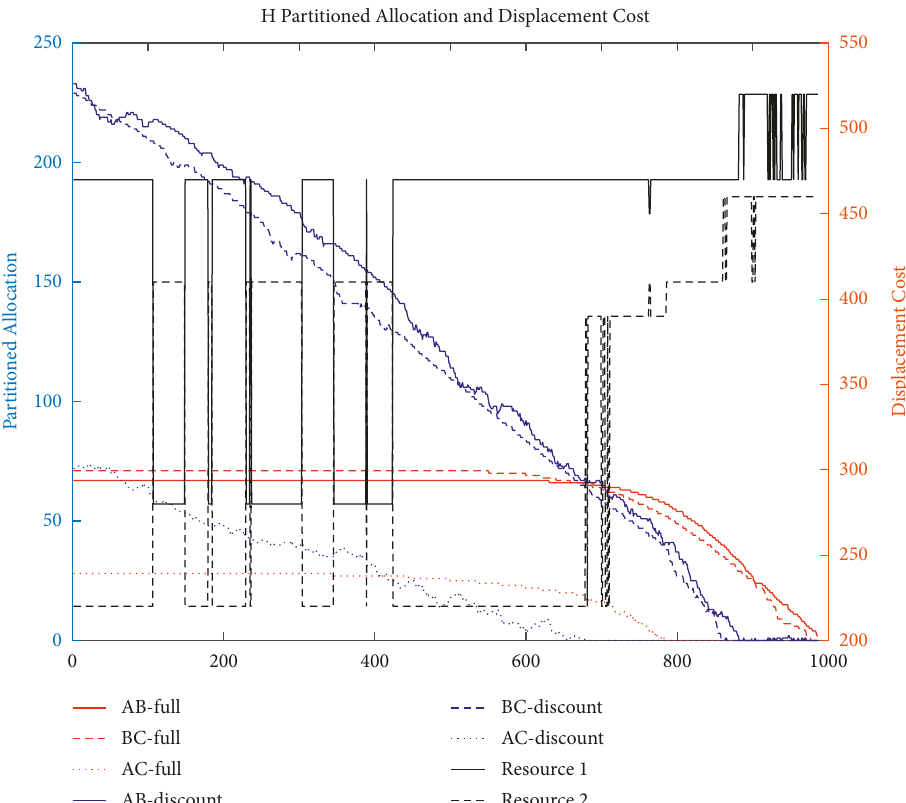
Figure 9: Partitioned allocation and displacement cost of